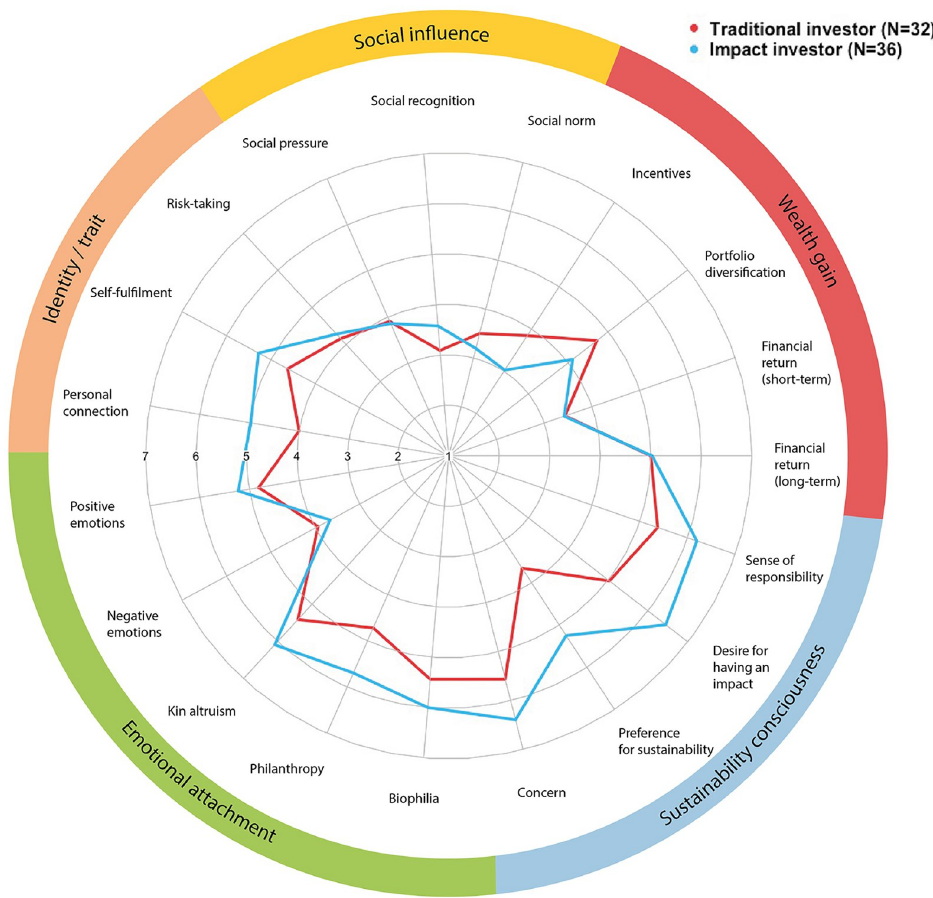
Fig 2. Influences of different motives on making sustainable investments by investor type (1 = motive not influential at all, 7 = very influential motive; red = mean response from all (N = 32) traditional investors, blue = mean response from all (N = 36) impact